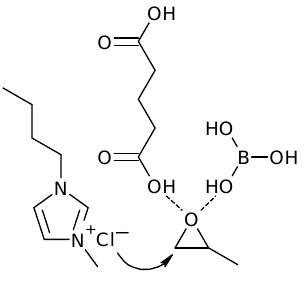
Figure 7. Activation of the epoxy ring by DES based on bmimCl, BA, and GA. Even greater progress was demonstrated by Yang et al. in their 2021 paper